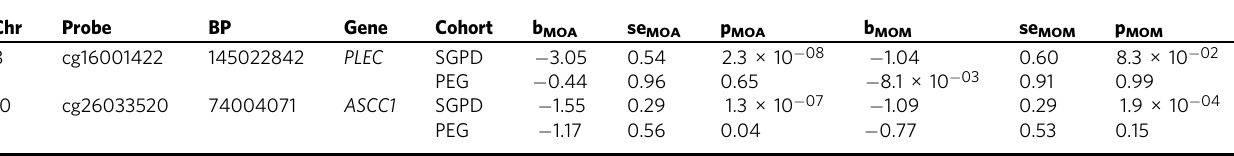
Results are shown for the two epigenome-wide signi fi cant probes in the MOA MWAS of SGPD, together with results for these probes from the MOMENT (MOM) MWAS of SGPD and the MOA and MOMENT MWAS ’ s of the PEG replication data. Effect sizes (b) and standard errors (se) from OSCA are not